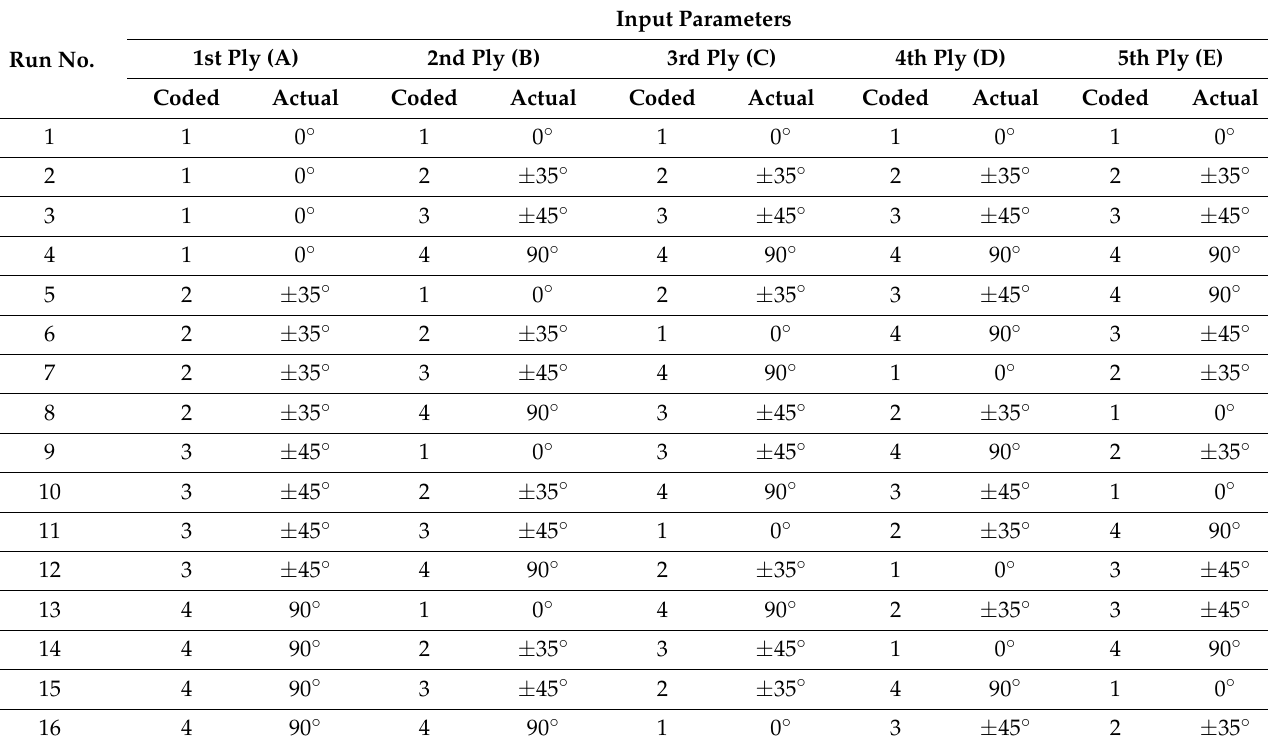
Table 1. Various configurations used for this study.